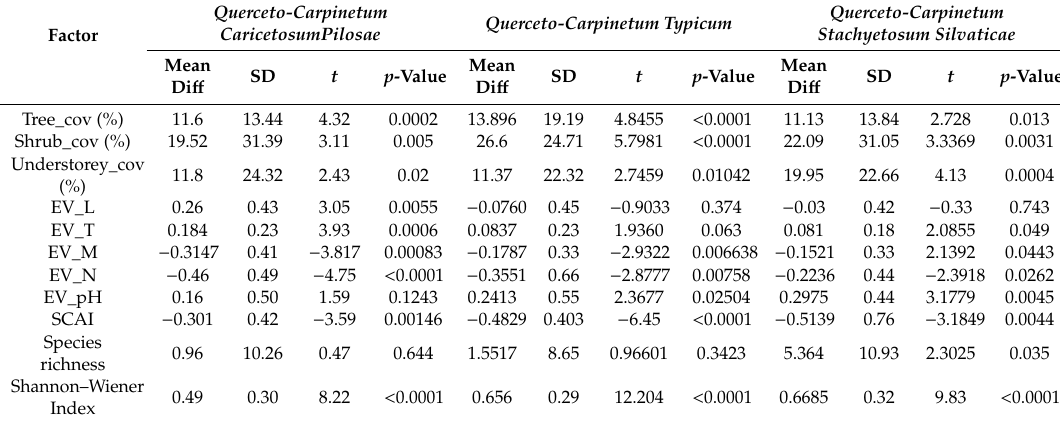
Table1. Meandi ff erencesbetween1949and2018inTree_cov—treecrowncover, Shrub_cov—shrublayer cover, Undersorey_cov—understorey cover, EV_L—mean light Ellenberg Index Value,